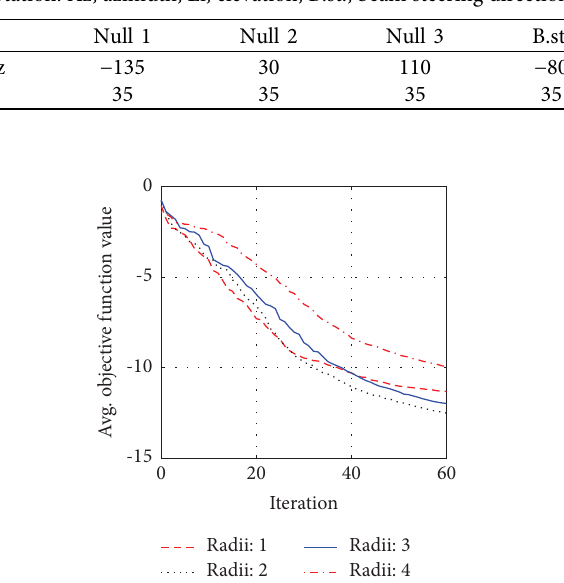
Table 15: Nulling and beam steering directions (in degrees).